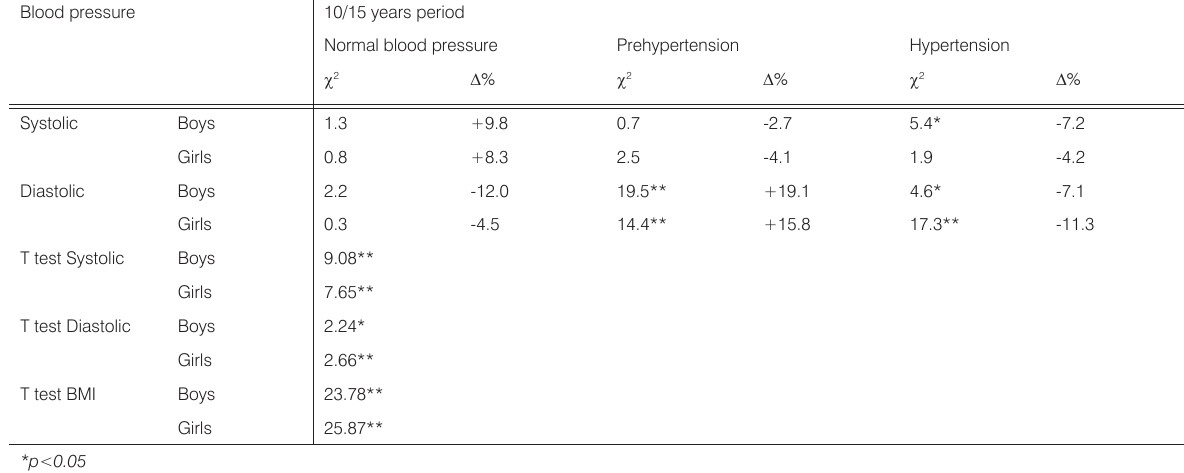
Table 2 Evaluation of blood pressure and BMI in children age between 10 and 15 years Blood pressure